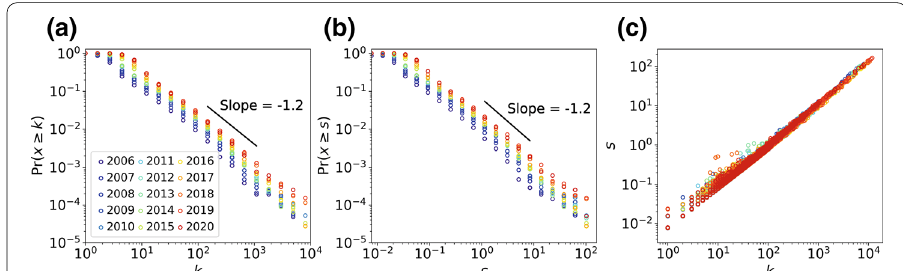
Fig. 2 Complementary cumulative distribution function (CCDF) of a the degree k and b strength s (for the fitting of power law, see Additional file 1: Section S.1). Each colour represents each year. The relationship between the degree and strength of each node is shown in